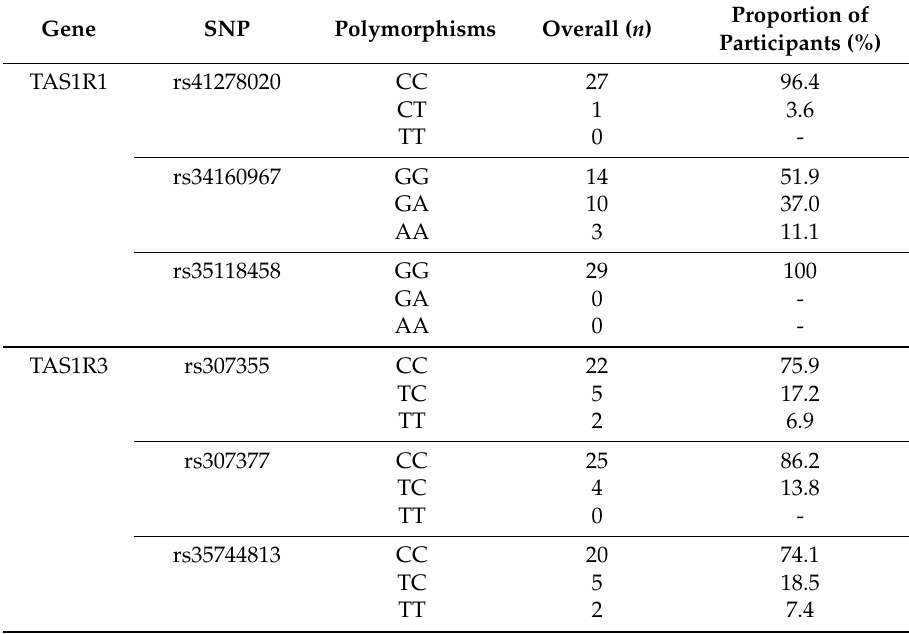
Table 3. Allelic distribution for selected SNP expressed as proportion of participants (%). Gene SNP